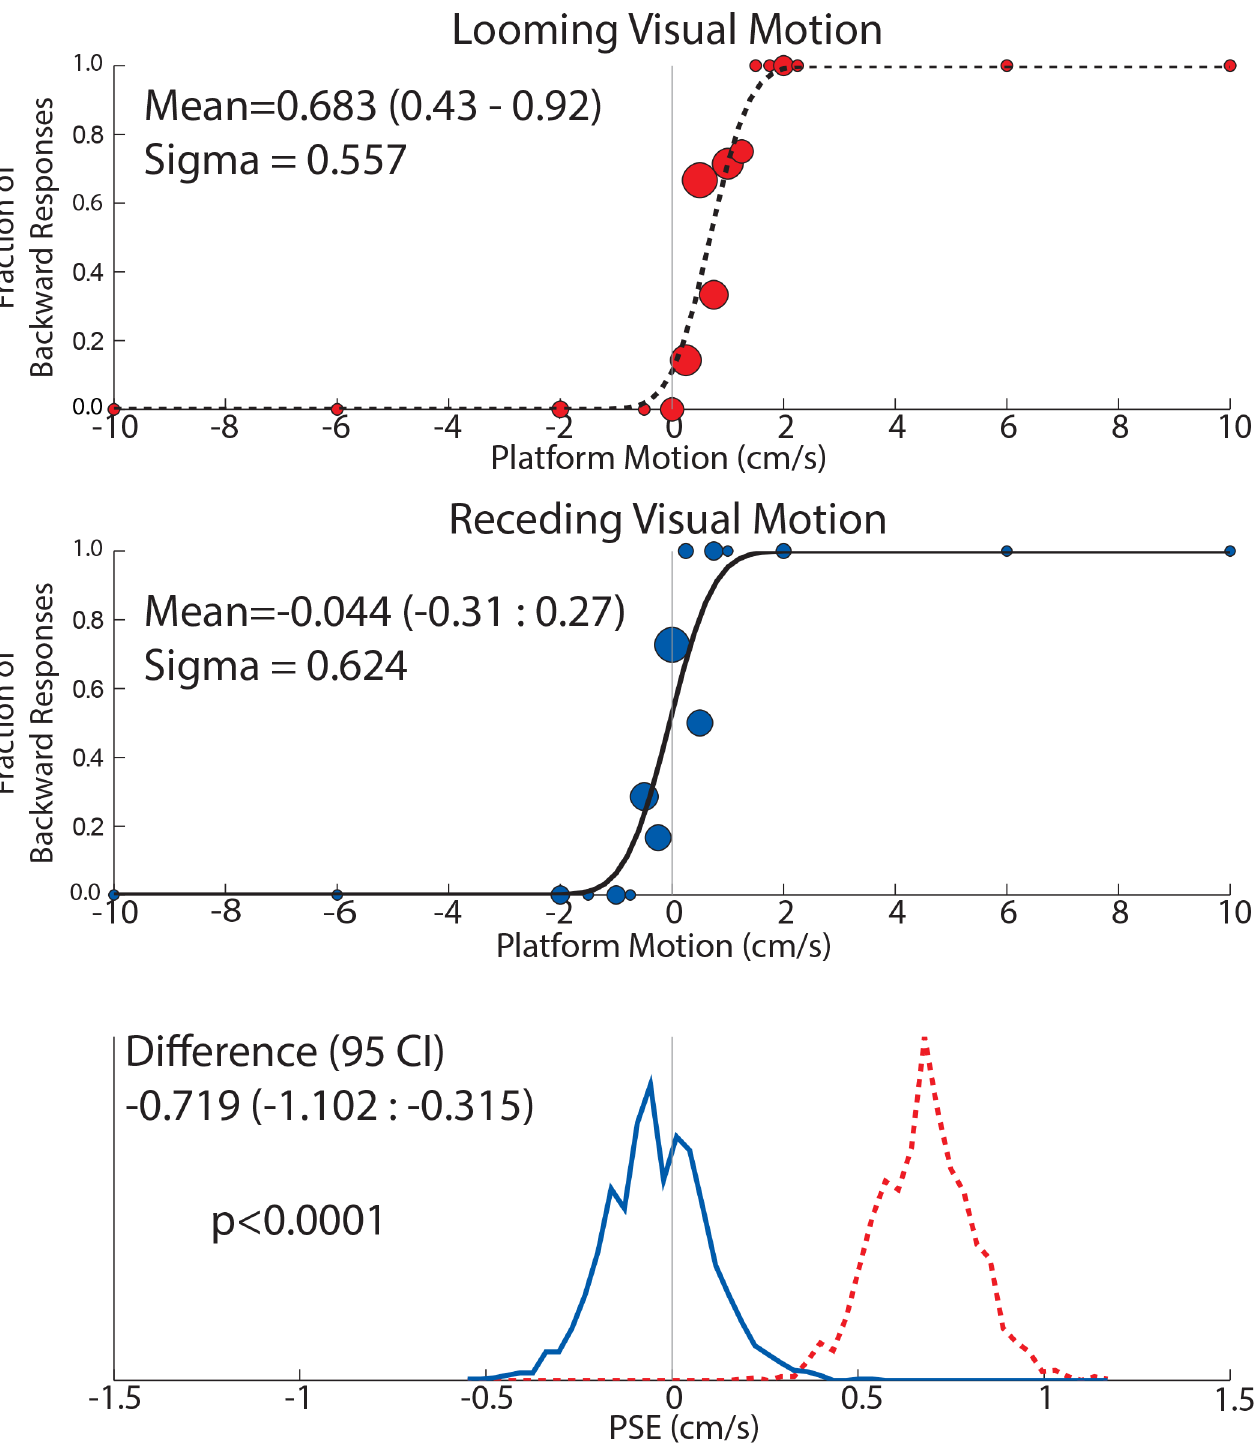
Fig 3. Data from a block of trials in an individual subject (subject 12, from Exp 2). In this block there was a 8s visual stimulus. Circles in the two upper panels are sized proportionally to the number of responses represented. A cumulative distribution function (CDF) was calculated from each data set as a method for determining the mean (bias) and sigma (threshold) of inertial motion detection for each test condition. In this subject, the CDF had a significant shift towards the right when looming VFM was presented (top panel, dashed curve) when compared with receding VFM (middle panel, solid curve). Thus for when there was no inertial motion, looming VFM was reported as forward self-motion. Each CDF was fit to the data 2,000x after being randomly resampled